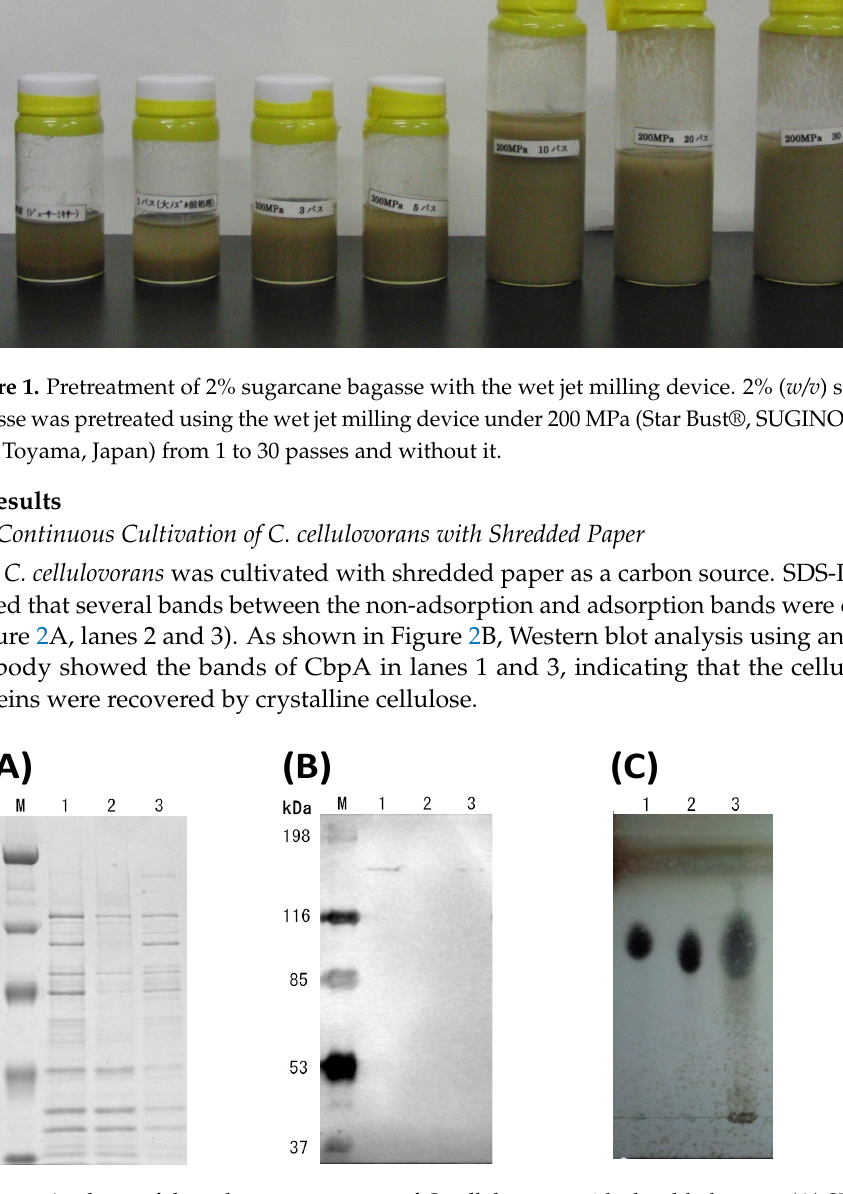
Figure 1. Pretreatment of 2% sugarcane bagasse with the wet jet milling device. 2% (w/v) sugar- cane bagasse was pretreated using the wet jet milling device under 200 MPa (Star Bust®, SUGINO Machine Ltd., Toyama, Japan) from 1 to 30 passes and without it.